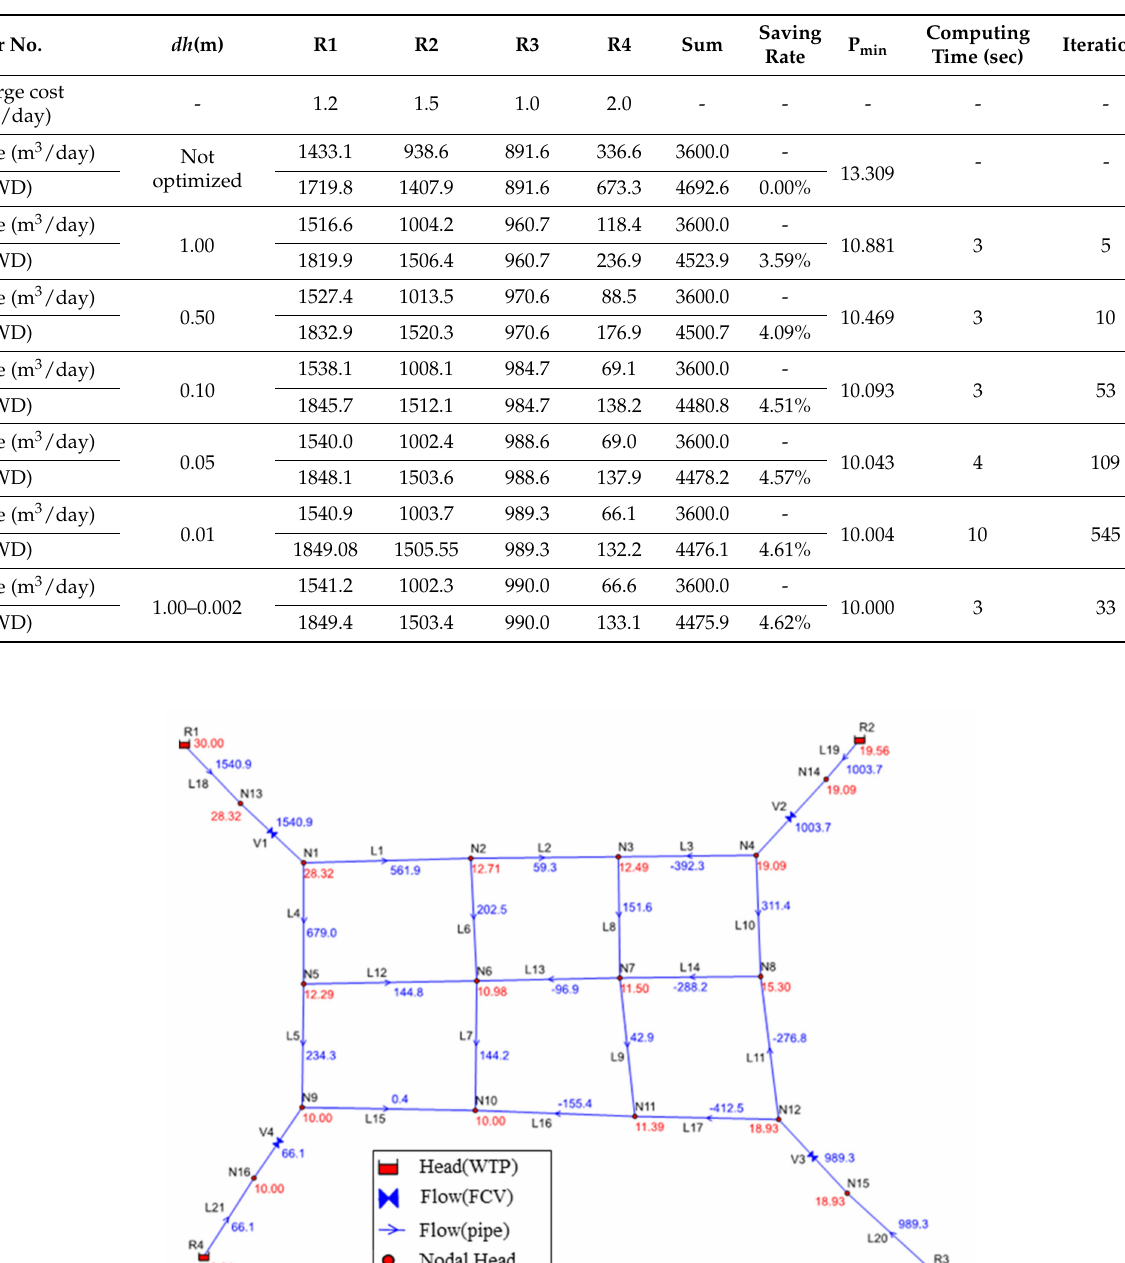
Table 3. Optimization results of water discharge and total cost for each WTP in Case 1.